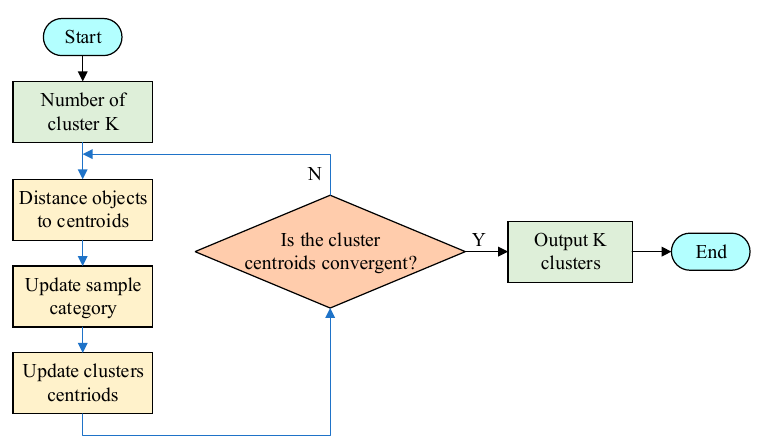
Figure 9. K-means clustering algorithm.